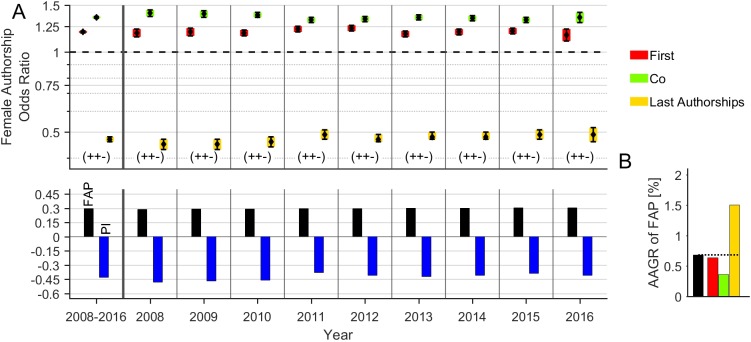
Time trend of female authorships on the global level.(A) The relative frequency of female authorships (FAP, bottom), the pattern of FAORs (with FAOR-triplet, top) and its associated Prestige Index (PI) are depicted by year and averaged over time. The very time-stable and unbalanced FAOR distribution is constantly characterized by the FAOR-pattern (+, +, -). The significantly negative PI points to a lack of prestigious authorships held by women. (B) The FAP exhibits a marginal increase as documented by its average annual growth rate (AAGR) of 0.7% per year with the highest rate for last authorships (1.5%).